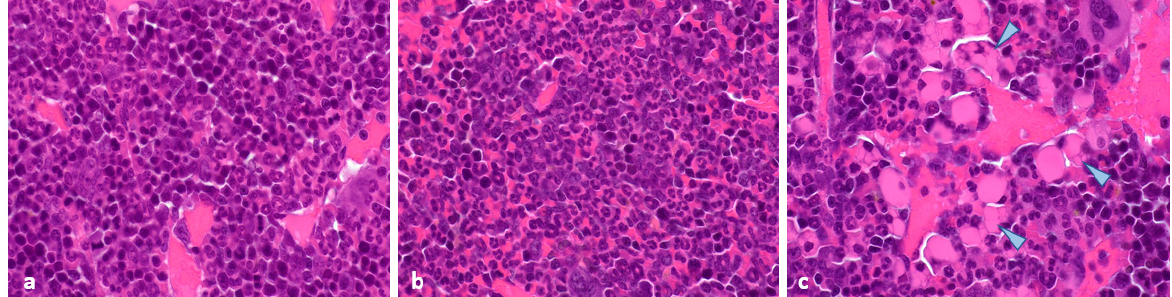
Figure 8. Histopathological analyses of the bone marrow at 96 h post administration of last treat- ment and at the end of study. Compared to a control bone marrow ( a ), similar treatment-related toxicity was observed in all three treated groups, which was mainly characterized by an increased myeloid/erythroid ratio ( b ) at 96 h after last administration. An increased myeloid/erythroid ratio was also noted at the end of the study in all study groups, with the presence of rare foci of eosinophilic vacuolated cells in a limited number of animals treated with either [ 177 Lu]Lu-satoreotide tetraxetan at 15 MBq or [ 177 Lu]Lu-DOTA-TATE at 30 MBq ( c , arrowheads). Figures ( a – c ) were taken using the objective 100.